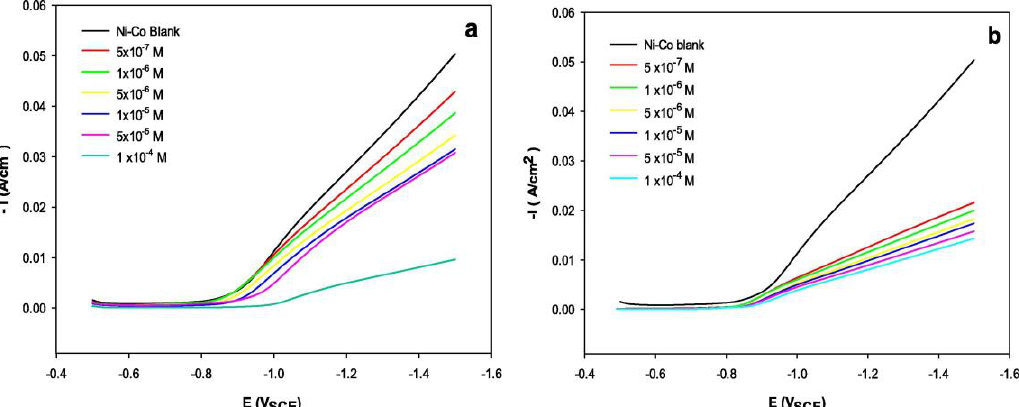
Figure 7. Potentiodynamic cathodic polarization curves for the Ni-Co alloy electrodeposition from the Ni70%-Co30% bath in the absence and presence of different concentrations of ( a ) [MOFIM]I, ( b ) [FPIM]Br at pH 4.5. Reproduced from [19] with permission from Elsevier, 2021.